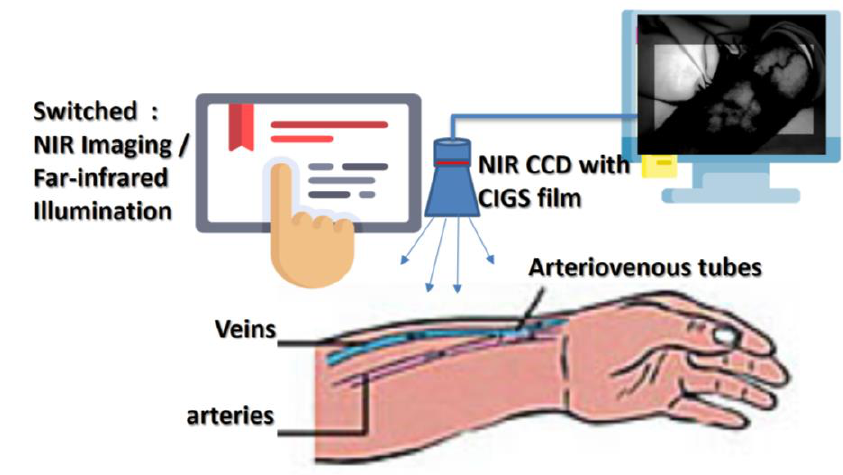
Figure 7. A filter with a bandpass wavelength of 1000–2300 nm was placed in front of each imaging system to eliminate ambient light.